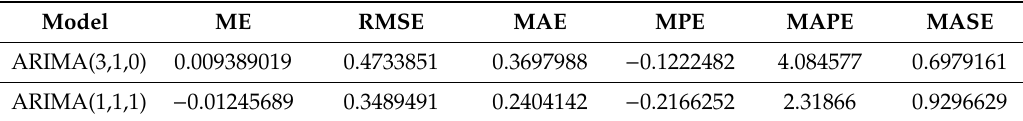
Table 4. Error measures for the ARIMA model.